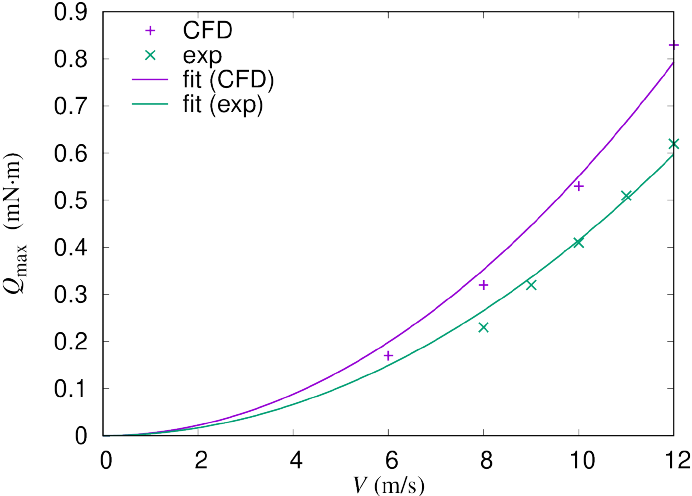
Figure A1. Q max from Figure 2 of Ref. [14], Figure 3 of Ref. [8], and their fitting curves are shown. Second, let us show the dependence of ω 0 on flow velocity V , also read from Figure 2 of Ref. [14] and Figure 3 of Ref. [8]. Figure A2 shows the CFD and experimental data, as well as their fitting curves taken to be linear in V . Although the number of data points is not enough, the fitting curves appear to agree well with the CFD and experimental data.